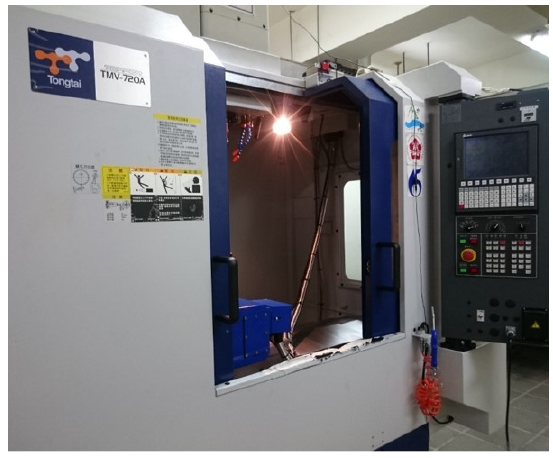
Figure 6. Tongtai TMV-720A vertical milling machine.